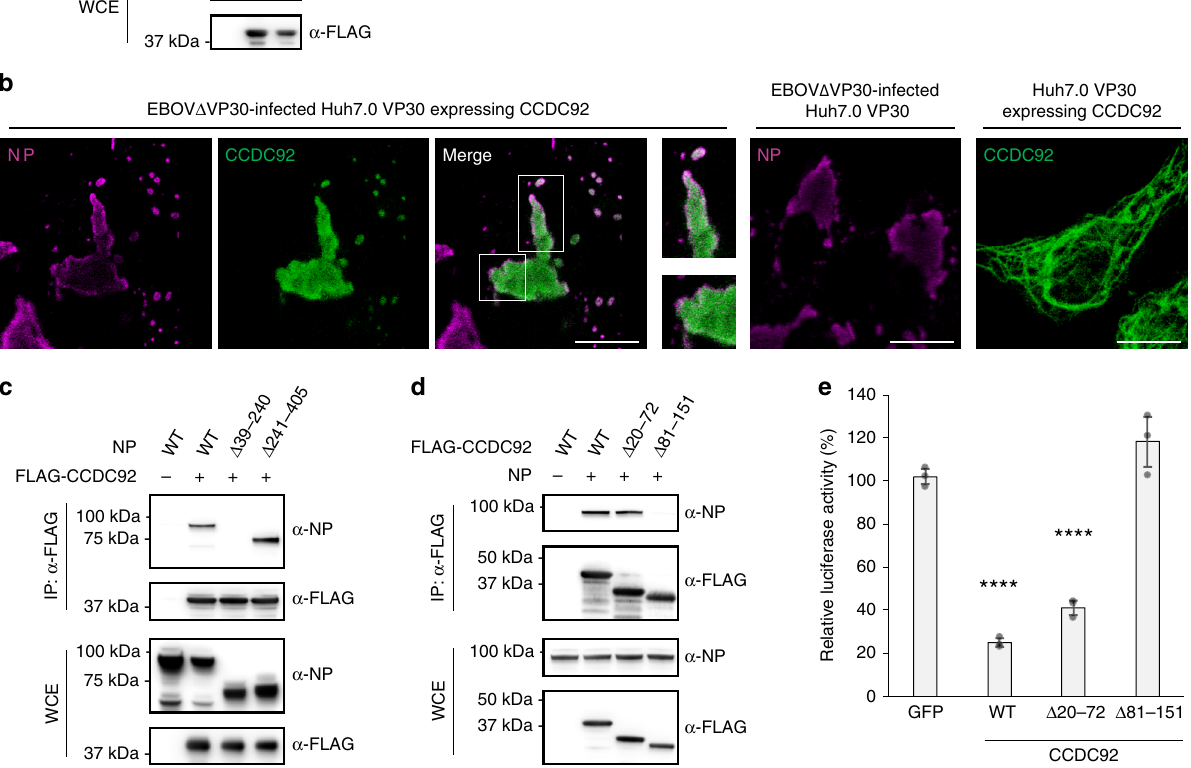
Fig. 4 Interaction of CCDC92 with NP. a Interaction between NP and CCDC92 in HEK-293T cells transfected with the indicated combination of expression vectors. Cell lysates were immunoprecipitated with anti-FLAG antibody followed by immunoblotting. Data are representative of three independent experiments. IP, immunoprecipitation. WCE, whole-cell extract. b EBOV NP (magenta) and/or CCDC92 (green) in Huh7.0 VP30 cells infected with EBOV Δ VP30 24 h prior to transfection with CCDC92 expression vector were visualized with speci fi c antibodies and analyzed by confocal microscopy. The enlarged images corresponding to the boxed areas are shown next to the original image. Data are representative of two independent experiments.